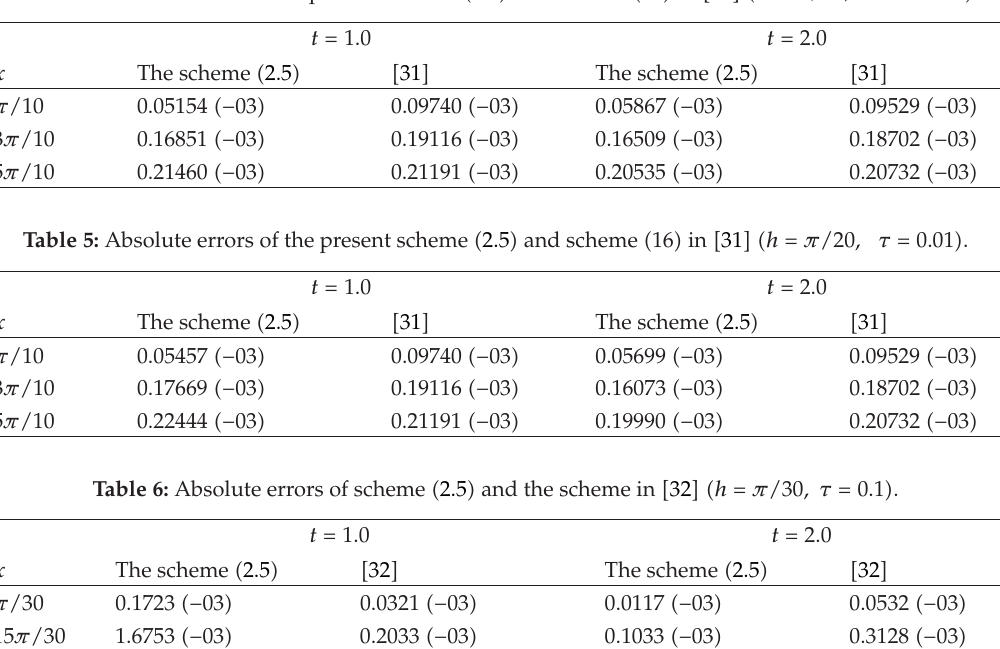
Table 4: Absolute errors of the present scheme (cid:3) 2.5 (cid:4) and scheme (cid:3) 16 (cid:4) in (cid:6) 31 (cid:7) (cid:3) h (cid:9) π/ 20 , sτ (cid:9) 0 . 001 (cid:4) .